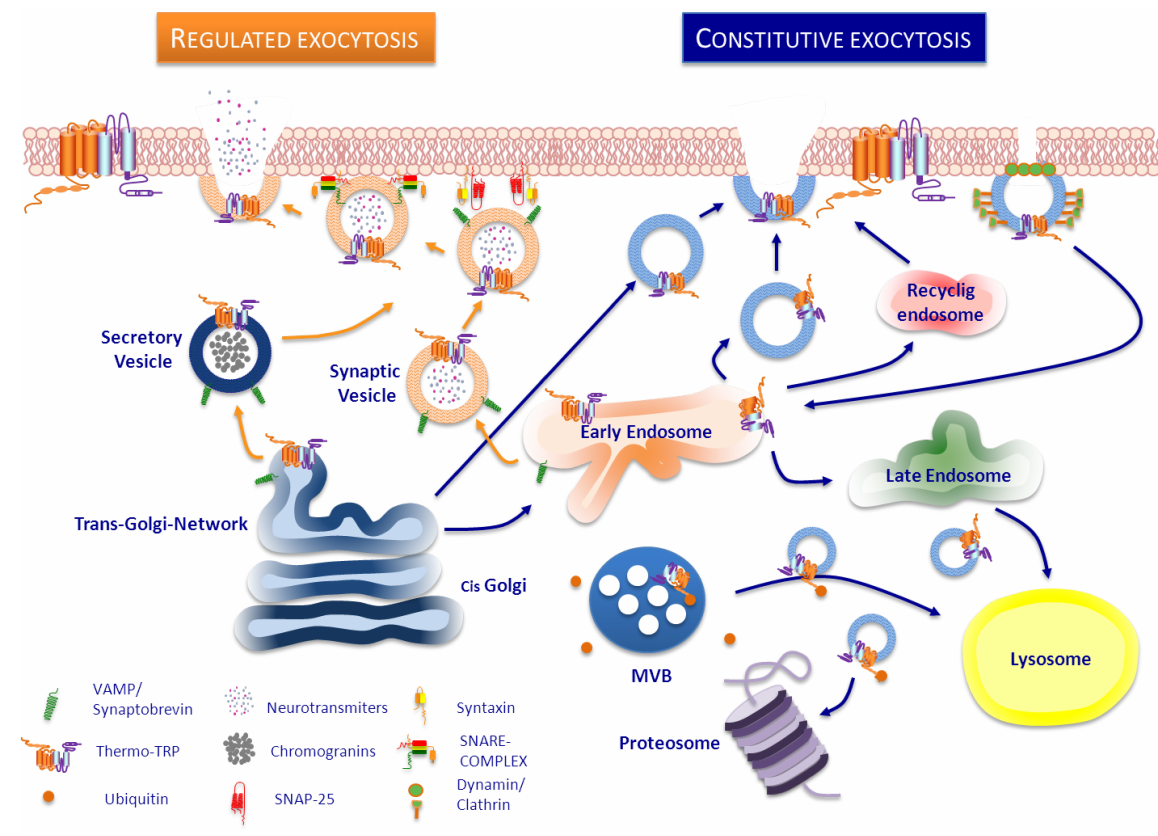
Figure 2. Trafficking pathways of ThermoTRP channels to the plasma membrane. A neuron is illustrated here as example. ( Left side). Regulated vesicles such as synaptic vesicles, filled with neurotransmitters, or secretory vesicles such as large dense core vesicles, that contain neuropeptides, can also store thermoTRP channels which are delivered to the cell surface upon stimulation by secretagogues. Docking, priming and fusion of these vesicles into the plasma membrane is a SNARE-complex and Ca 2+ -dependent process. ( Right side). In the constitutive pathway, thermoTRP channels reach plasma membrane by a constant exocytosis from the trans-Golgi directly or via early endosomes (EE). Membrane levels of thermoTRP channels can be also regulated through the classic clathrin-dependent endocytosis pathway, in which dynamin form a ring around the neck of clathrin-coated pit, leading to formation of clathrin-coated vesicles which transport membrane proteins to EE. Once there, proteins could be sorted either into late endosomes and lysosomes or recycled to cell surface via recycling endosomes. ThermoTRP channels destined to degradation could be sorted into intraluminal vesicles of a multi vesicular body (MVB) and lead to lysosome or could be ubiquitinated and lead to